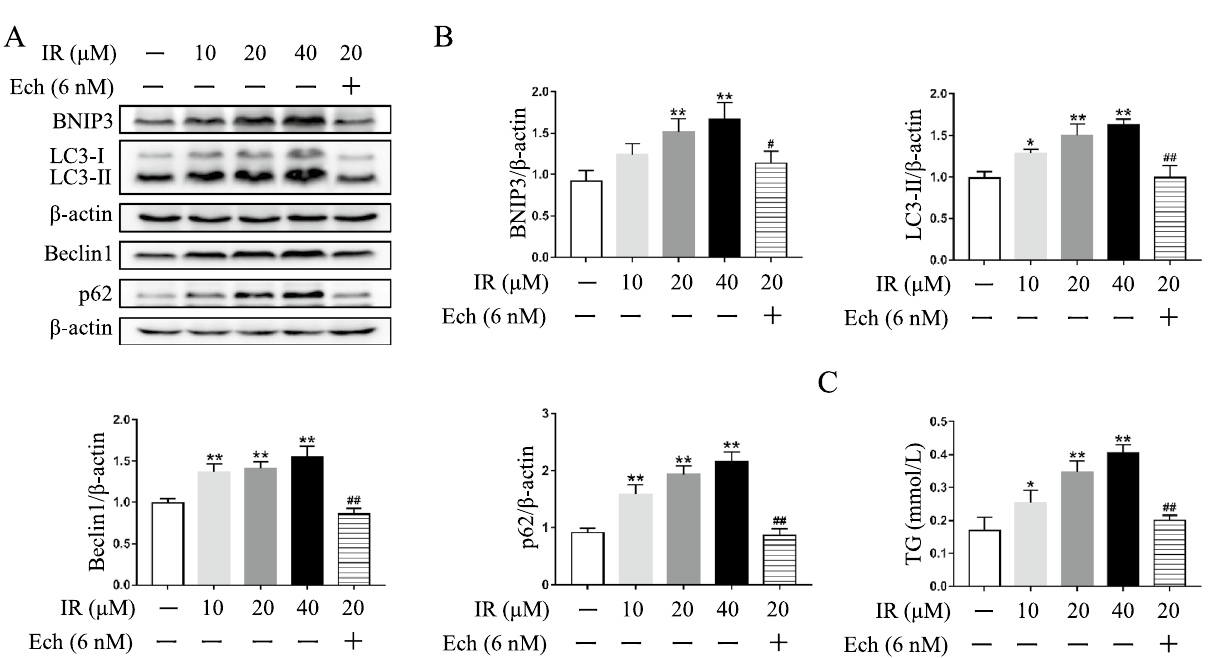
Figure 6. Echinomycin (Ech) mitigates autophagosome accumulation and lipid deposition in irinotecan (IR)- treated L-02 cells. L-02 cells were exposed to media supplemented with IR (10, 20, 40 μM) for 12 h-treatment and Ech (6 nM) were given during the last 6 h of 12 h-treatment. ( A ) Western blot analysis of BNIP3, LC3-II, Beclin1 and p62 protein levels in L-02 cells. ( B ) Densitometric quantification of BNIP3, LC3-II, Beclin1 and p62. ( C ) IR exacerbated TG content in L-02 cells and co-treated with Ech decreased cellular TG content. The blots were cut prior to hybridisation with indicated primary antibodies. Data are presented as mean ± SD (n = 3), * P < 0.05 and ** P < 0.01 compared with normal control group, # P < 0.05 and ## P < 0.01 compared with 20 μM IR-treated